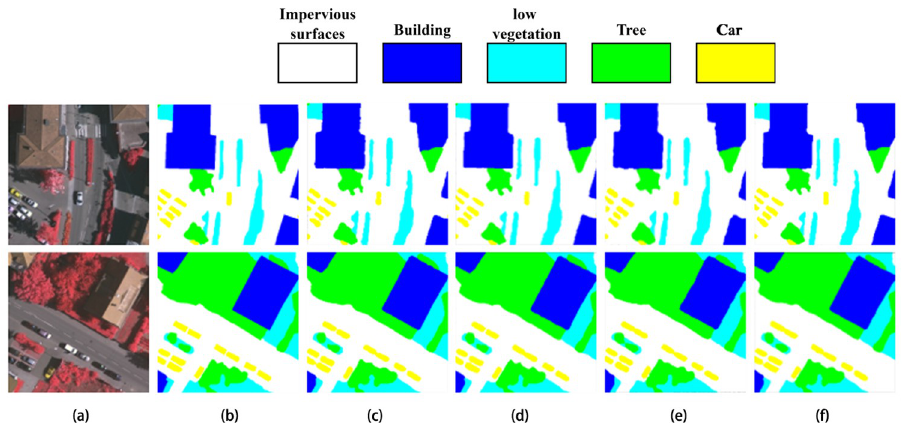
Fig 7. Comparison of segmentation results on ISPRS Vaihingen dataset. (a) The original image; (b) The label; (c) The segmentation result of Dv_Xtion; (d) The segmentation result of Dv_Mnetv2; (e) The segmentation result of BiSeNetV2; (f) The segmentation result of EMNet. Reprinted from [17] under a CC BY license, with permission from [DGPF], original copyright [2010].